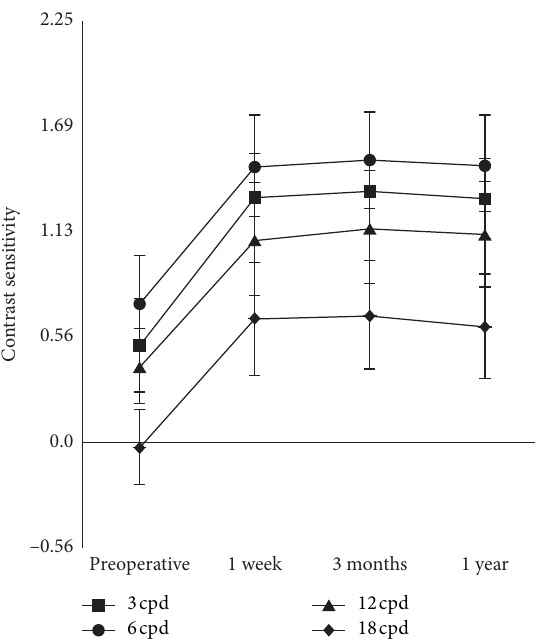
Figure 3: Preoperative and postoperative contrast sensitivity values ( n � 144 eyes) (cpd, cycles per degree).